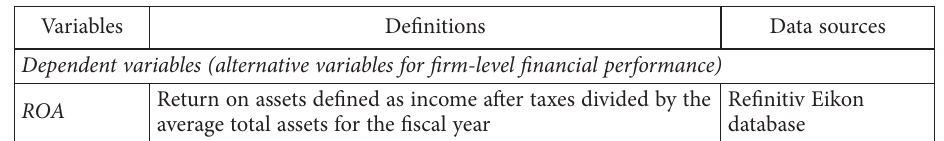
Table 1. Selected